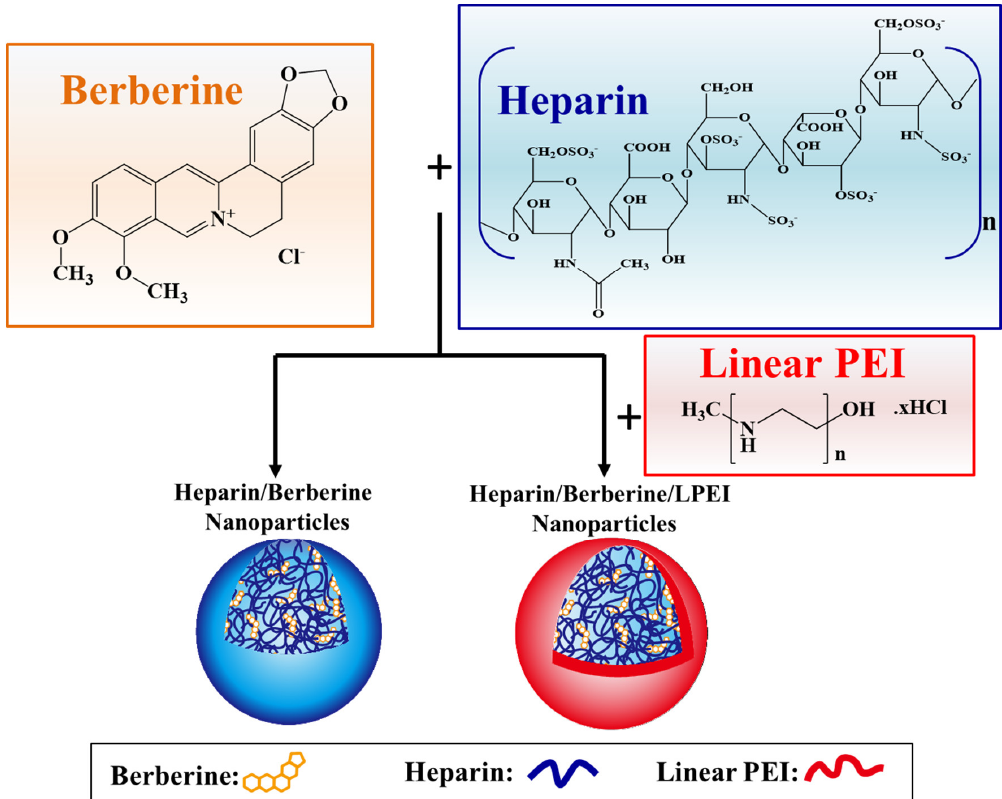
Figure 1. A schematic diagram of heparin (HP)/berberine (BBR) or HP/BBR/linear polyethyleneimine